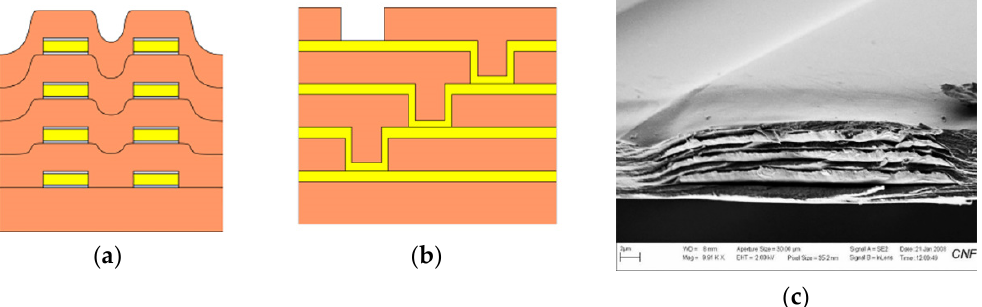
Figure 3. ( a,b ) Schematic cross section of a four-layer, flexible microfabricated lead structure for a multi-electrode array in which the separate, insulated 0.05 μm Ti/1.5 μm Au/0.05 μm Ti metal traces (light color) are separated by HD Microsystems PI-2611 polyimide layers (not to scale) and interconnected with metalized via holes; ( c ) SEM micrograph of a cross section of an as-fabricated structure of this type; as the number of metal layers increased, step coverage over previously patterned traces with photoresist became increasingly difficult, to the point where the use of >4 such layers introduced too many process defects [30]. Multiple layers permit the width of a high-density multi-electrode array to be reduced, and also permit crossing signals over from one layer to another.